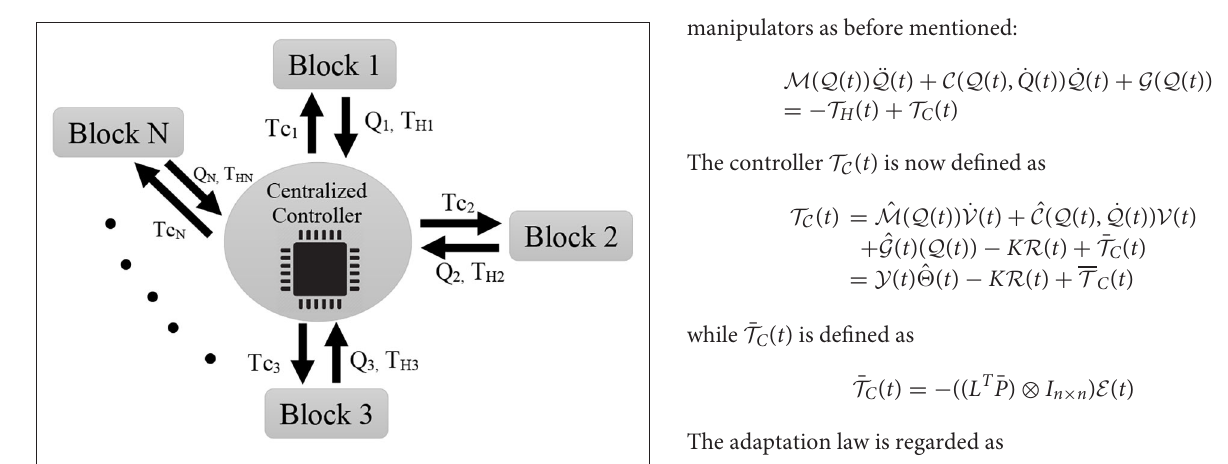
FIGURE 1 | Centralized controller. Each block sends its position and sensed force to the central controller. The central controller calculates the control torque using (8) and sends its associated part to each individual block